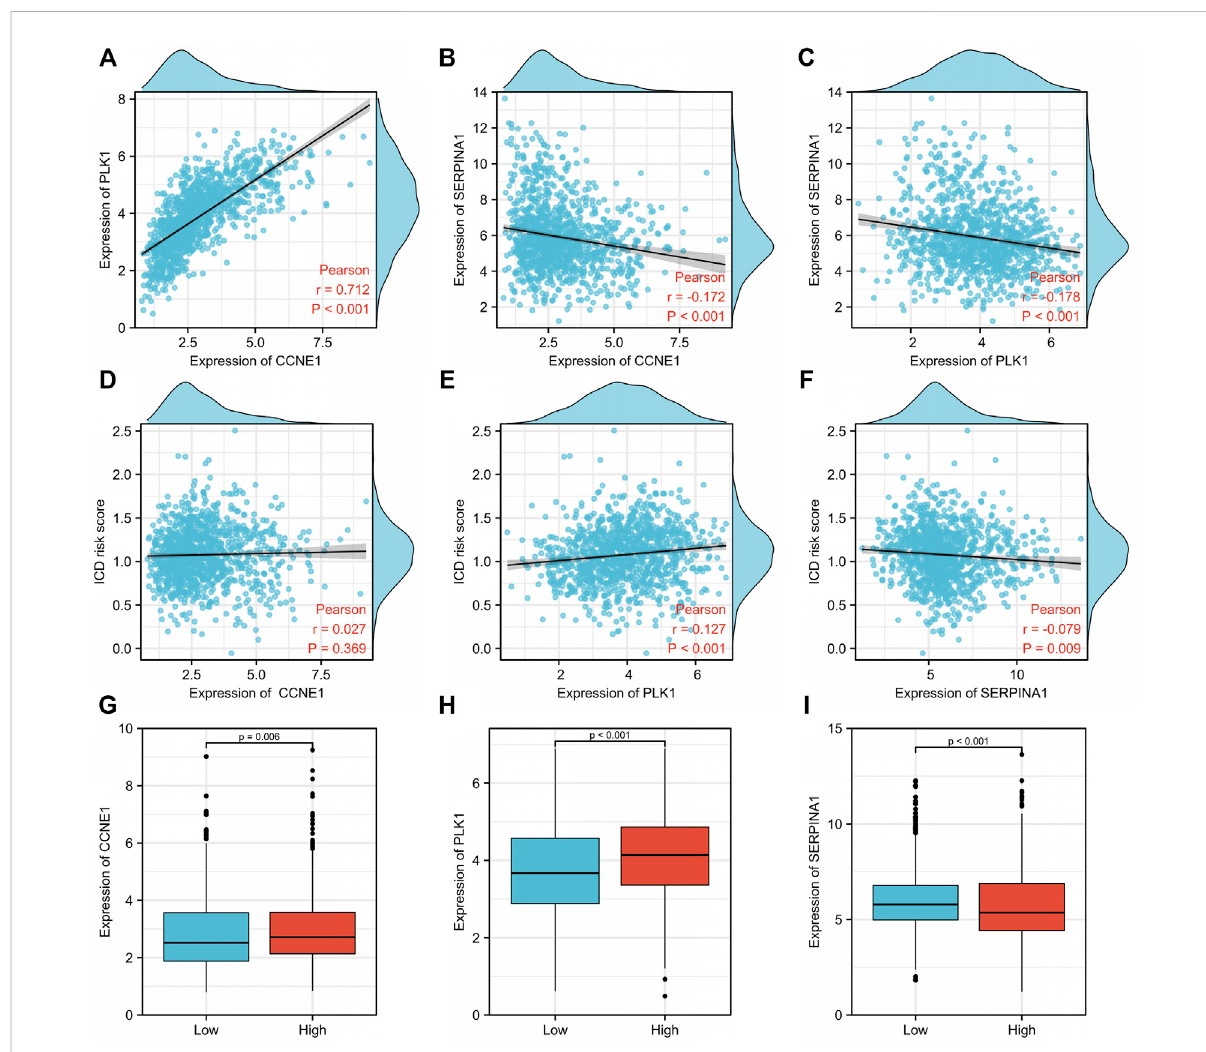
FIGURE 8 Relationshipbetweentumorantigensandimmunogeniccelldeath(ICD)risksignature.Pearsonanalysesbetweenexpressionof (A) CCNE1 and PLK1 , (B) CCNE1 and SERPINA1 , and (C) PLK1 and SERPINA1 . Correlation between the ICD risk score and (D) CCNE1 , (E) PLK1 , and (F) SERPINA1 . Expression levels of (G) CCNE1 , (H) PLK1 , and (I) SERPINA1 in low- and high-ICD-related risk